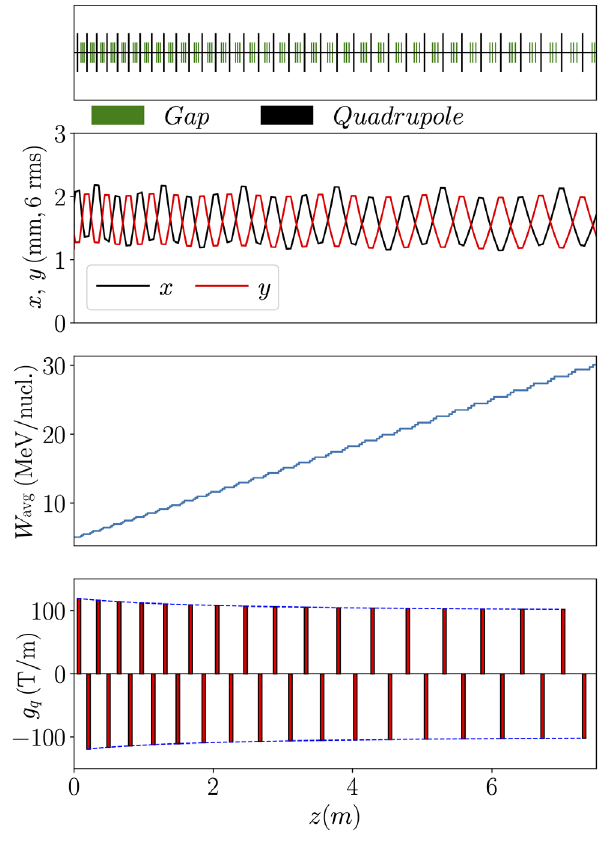
FIG. 4. From the top: the schematic of the linac (quadrupole positions in black, gap positions in green), the 6 rms x and y envelopes, the average kinetic energy, and the quadrupole